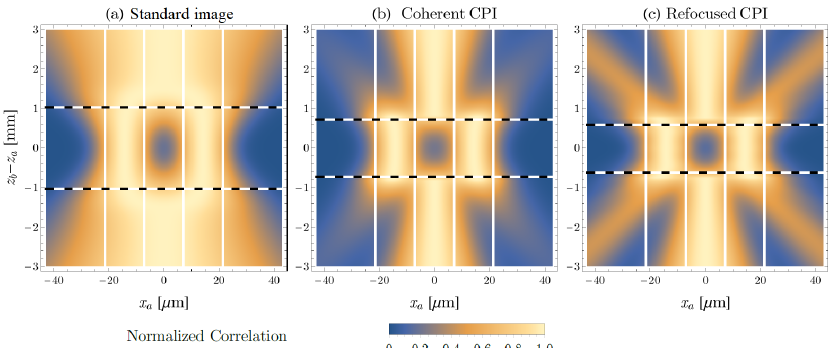
Figure 6. Comparison between: ( a ) the incoherent image, ( b ) the coherent image from CPI, and ( c ) the refocused image from CPI, for a double-slit mask of width a = 14 µ m = ∆ x f and slit separation d = 2 a . The density plots report the correlation functions of Equations (13)–(15), normalized to their value in x a = 0, for any value of z b − z a . The solid (white) lines represent the edges of the slits. The (black) dotted lines indicate the DOF, defined as the limits of z b − z a where the visibility drops below 10%. The images are from supplementary material, Ref. [42]. Reproduced with the permission from [42], copyright American Physical Society,